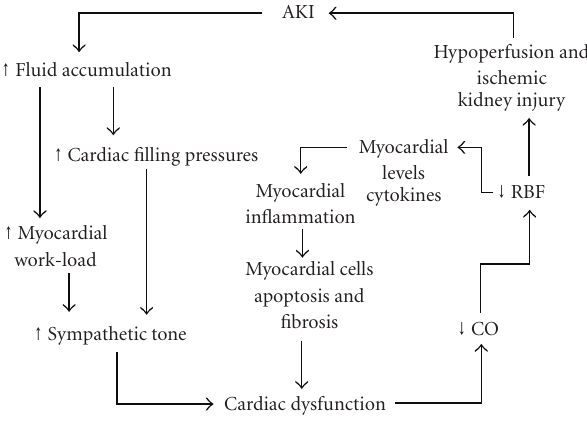
Figure 3: Organ “crosstalk” (see text for